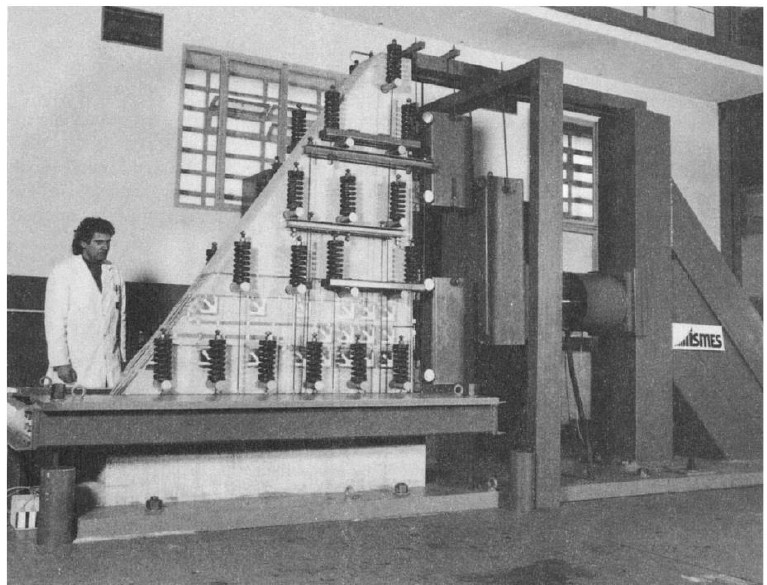
Figure 1. Experimental test performed in a 1:40 scaled-down model. From: Fracture Mechanics of Concrete Structures: Proceedings, Carpinteri et al. [9], Copyright © 1992 and Imprint. Reproduced by permission of Taylor & Francis Group.